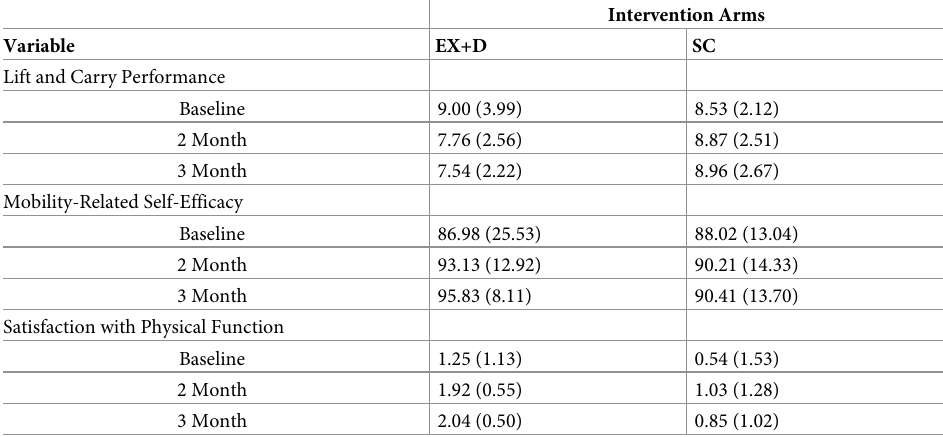
Table 1. Unadjusted means (SD) for lift and carry performance and task specific mobility-related